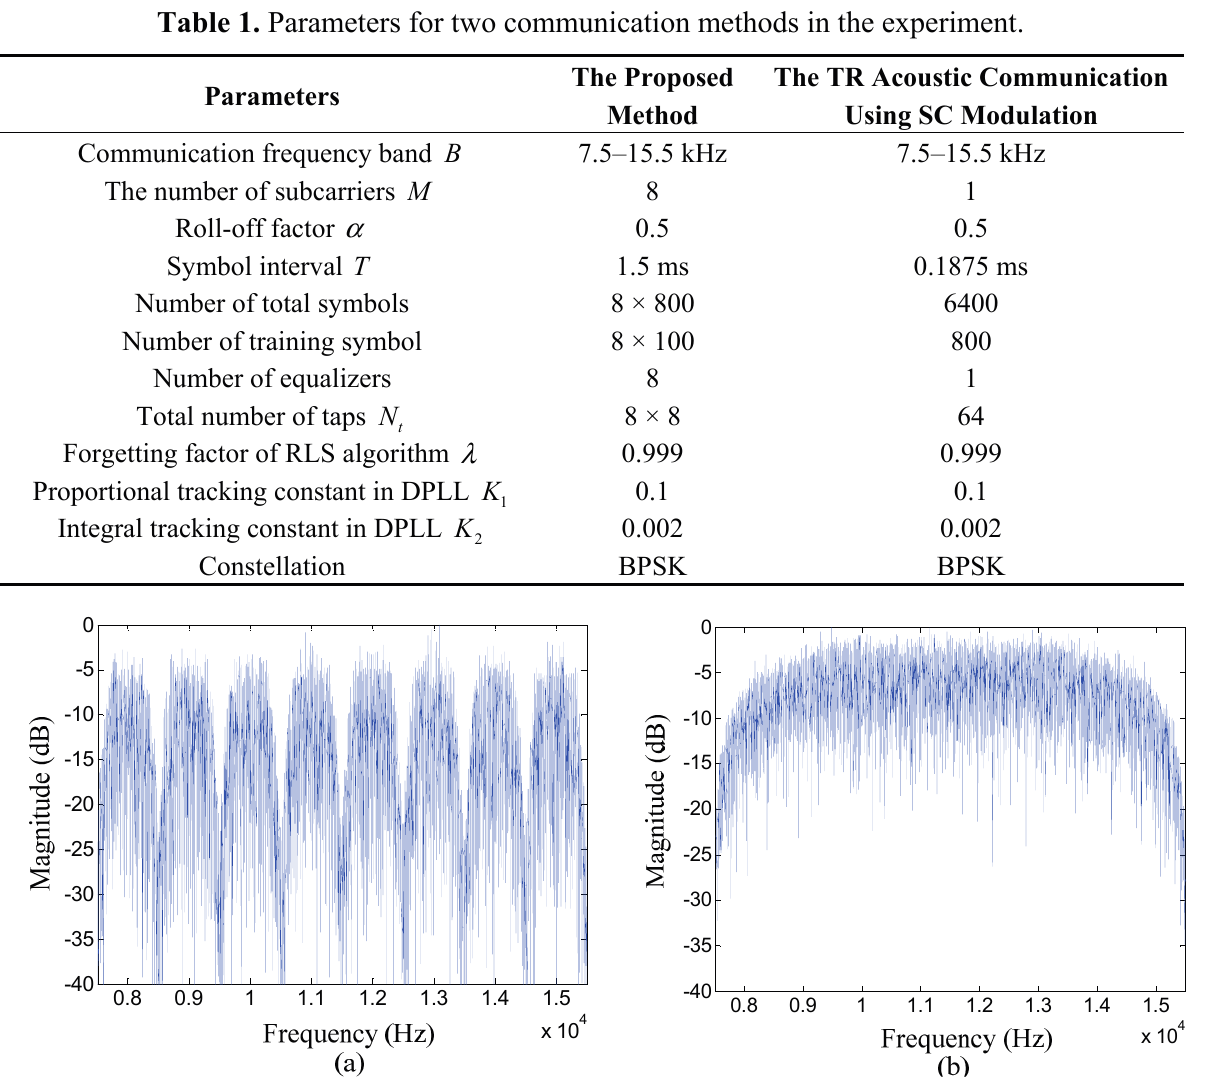
Figure 7. Comparison of the frequency spectrum of the information packet between two communication methods in the experiment: ( a ) the proposed method; and ( b ) the TR acoustic communication using SC